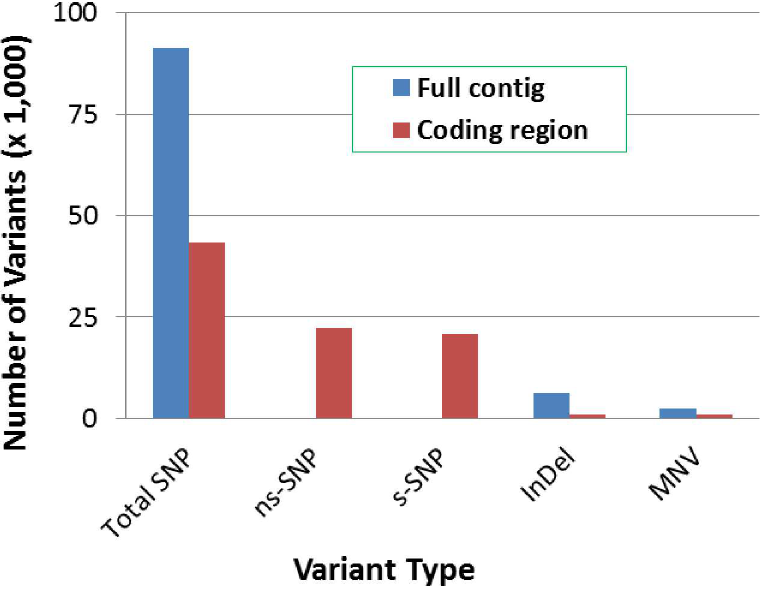
Fig 2. Classification of DNA variation in the whitebark pine transcriptome. Single nucleotide polymorphism (SNP), multiplenucleotidevariation(MNV), and small insertionsor deletions(InDel) were detected using CLC Genomics Workbench(v5.5). Synonymous and nonsynonymous SNPs (s-SNP and ns- SNP) were determined in the coding DNA